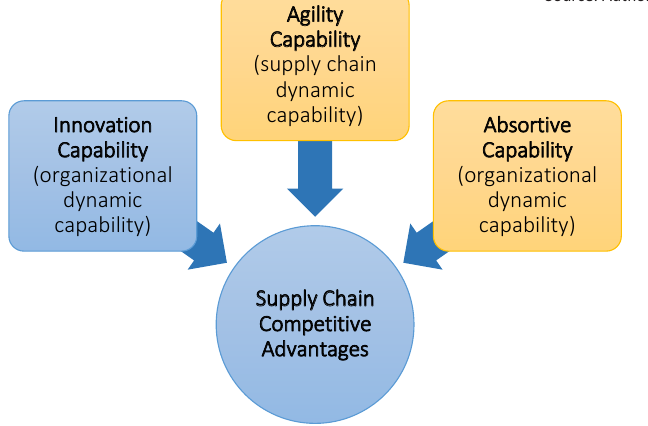
Figure 1. Organizational DC